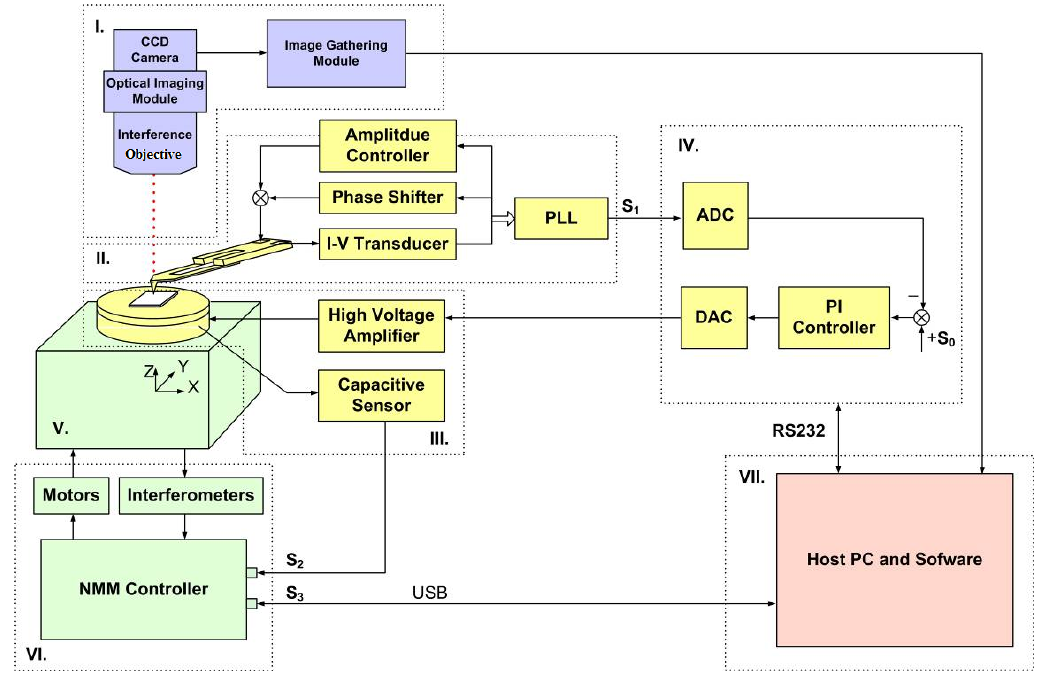
Figure 1. The schematic diagram of the hybrid AFM measurement